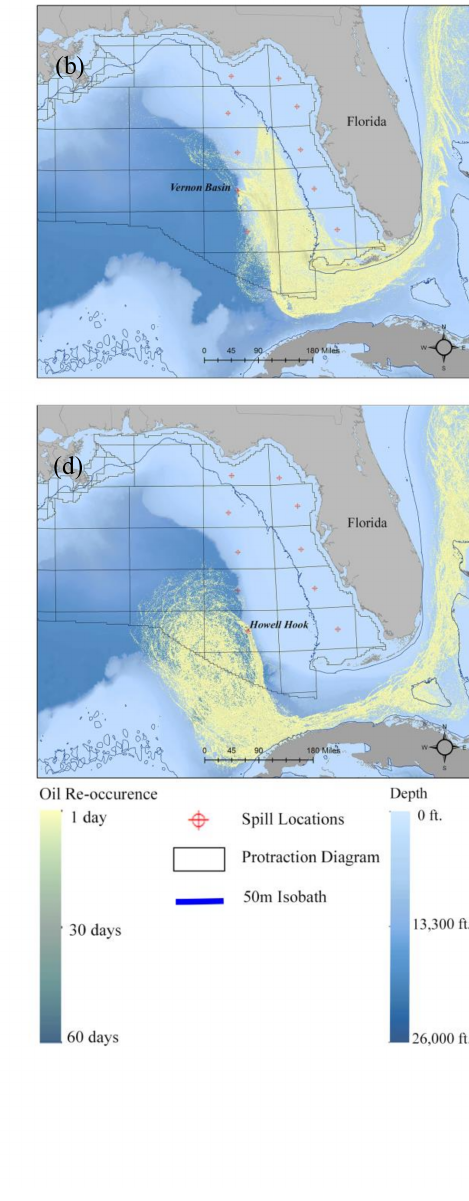
Figure 5. Western scenario oil plume extent and behavior over the 60-day simulation period. Plumes originating from the western locations were more dynamic and larger in extent, wrapping around Florida and out into the Atlantic Ocean. ( a ) (top left) depicts the 60 day plume from Apalachicola. ( b ) (top right) depicts the 60-day plume of Vernon Basin. ( c ) (middle left) depicts the 60-day plume from Florida Middle Ground. ( d ) (middle right) depicts the plume of Howell Hook and ( e ) (bottom left) depicts the plume of The Elbow. The plume is represented by the number of days that new oil particles moved through a specific